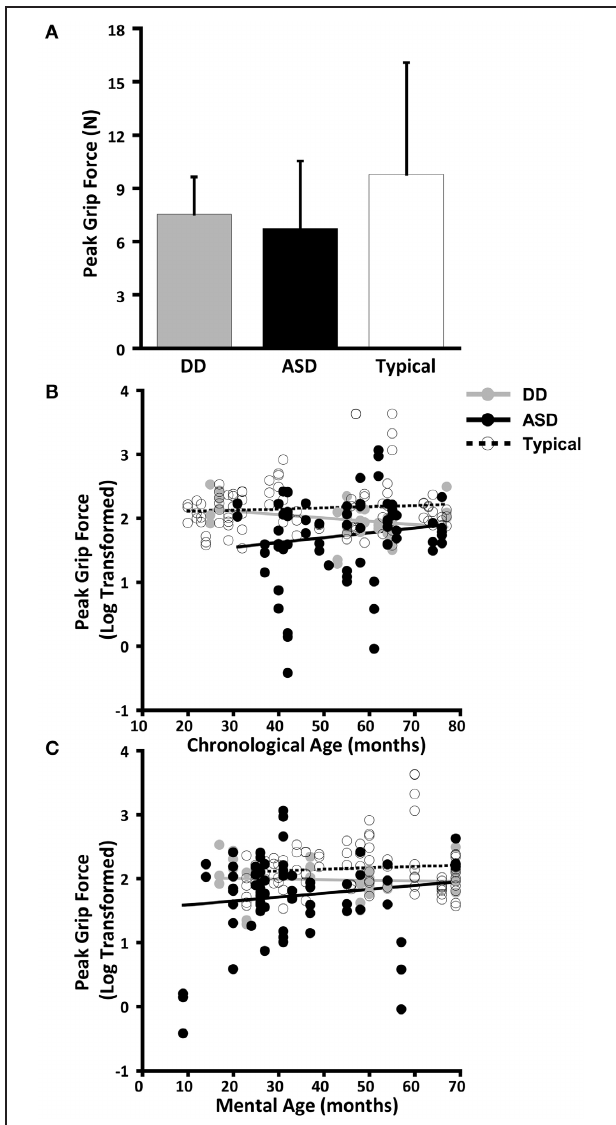
FIGURE 5 | Peak grip force. (A) Means and standard deviations. (B) The effect of chronological age. (C) The effect of mental age.